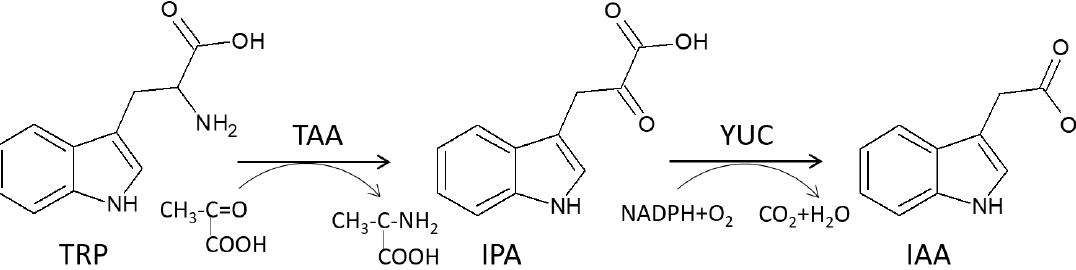
Figure 6. Transformation of Tryptophan to Indole-3-Acetic Acid in Plants, based on